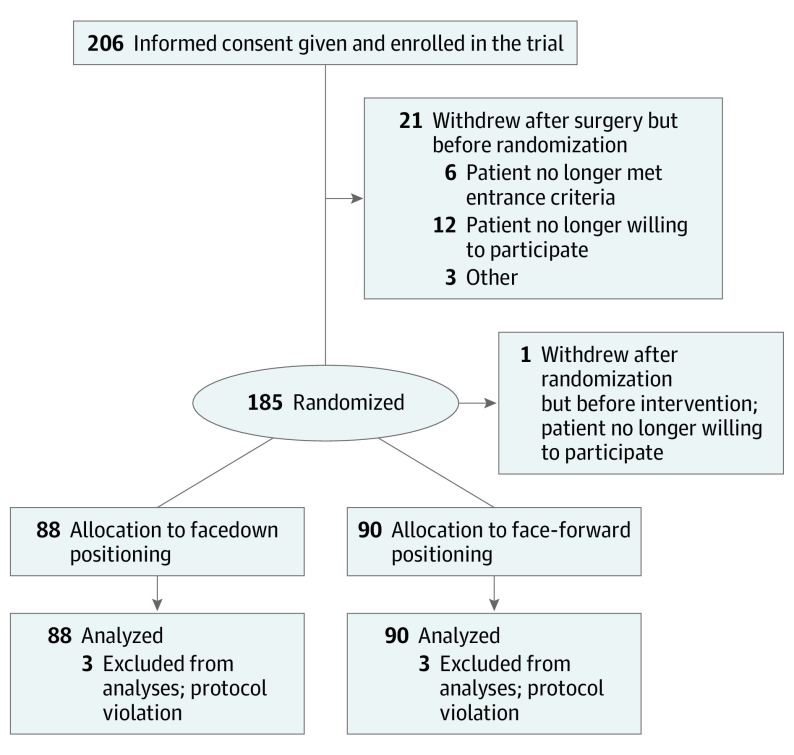
CONSORT Diagram